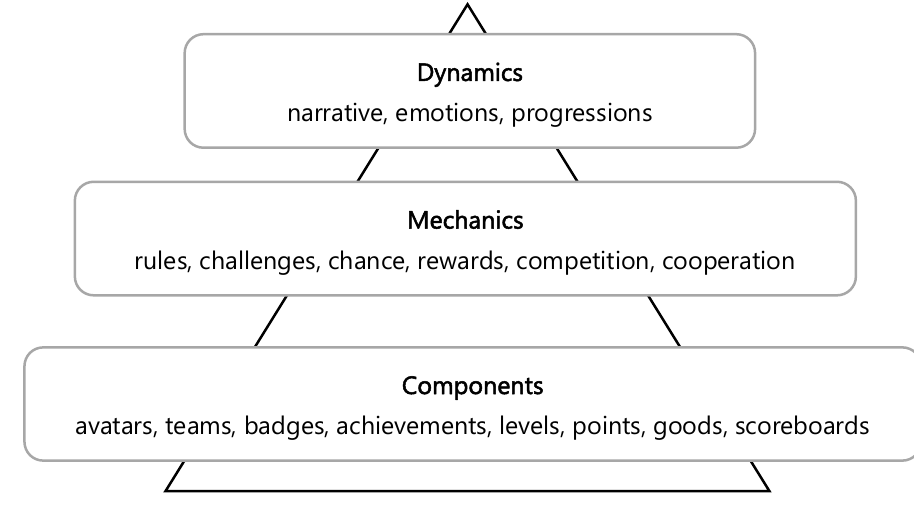
Figure 1. Game design elements. Adapted from Werbach and Hunter [9].